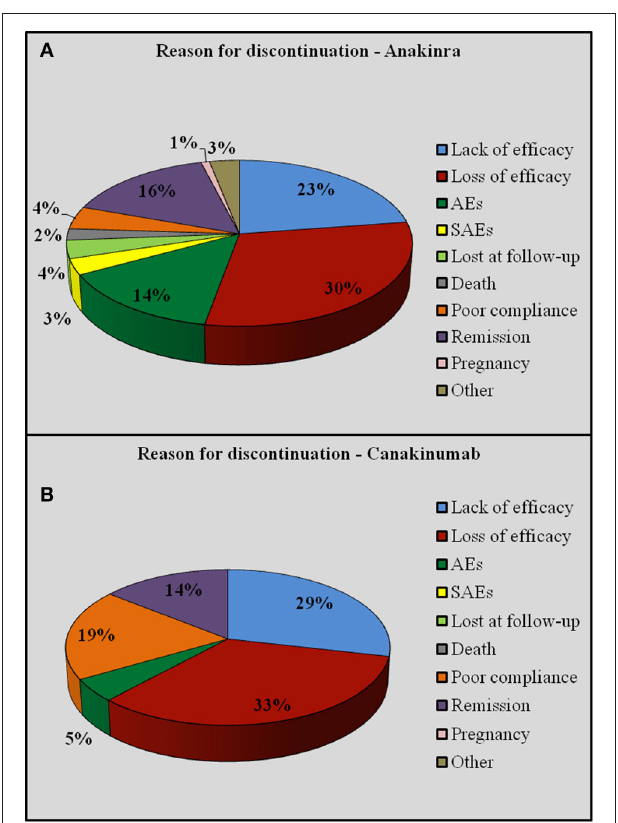
FIGURE 10 | Reasons for discontinuation distinguishing between Anakinra (A) and Canakinumab